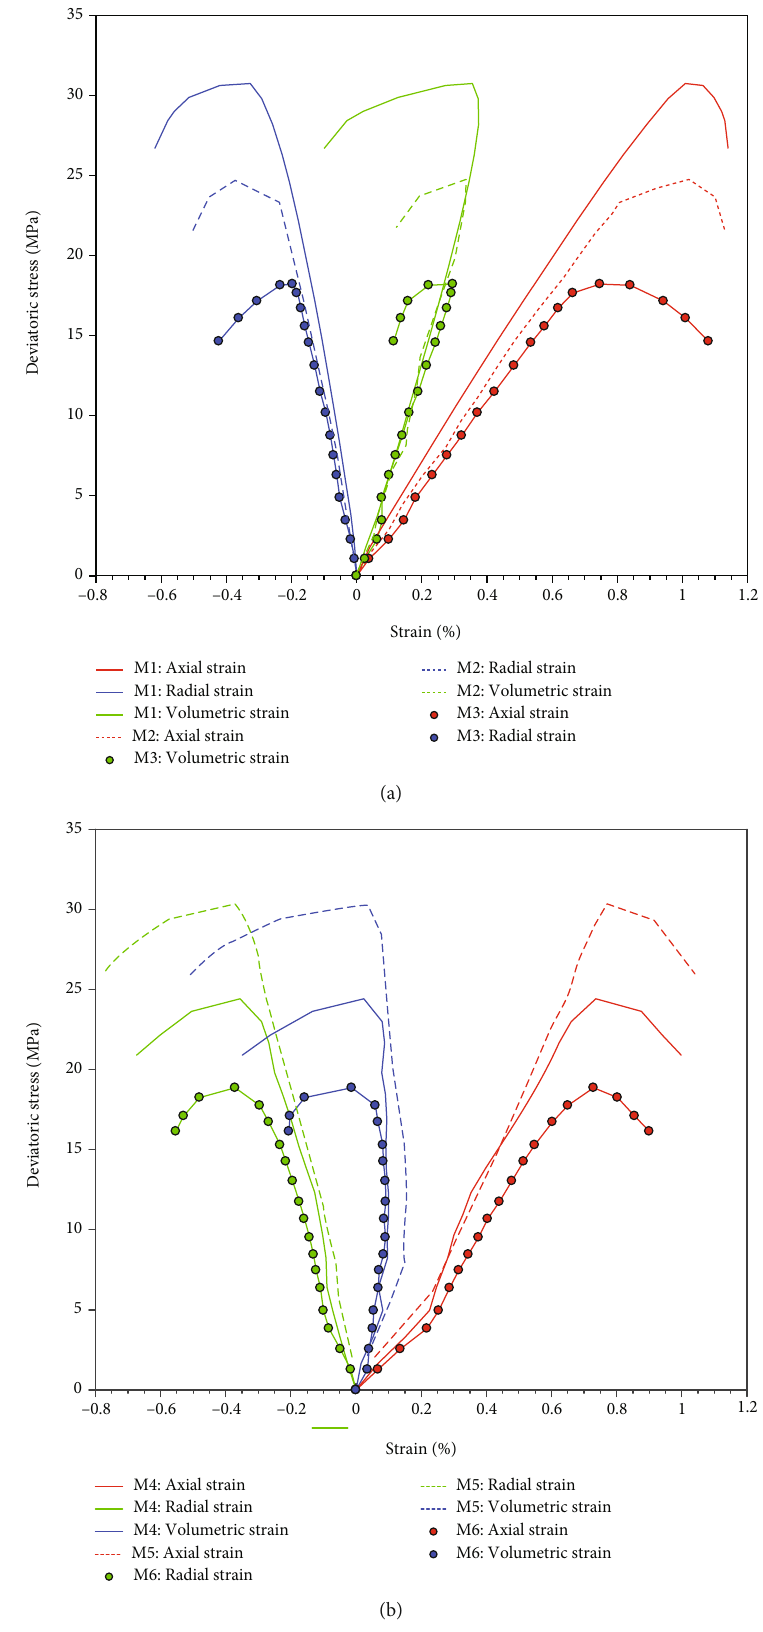
Figure 4: Deviatoric stress-strain of (a) samples M1, M2, and M3 and (b) samples M4, M5, and